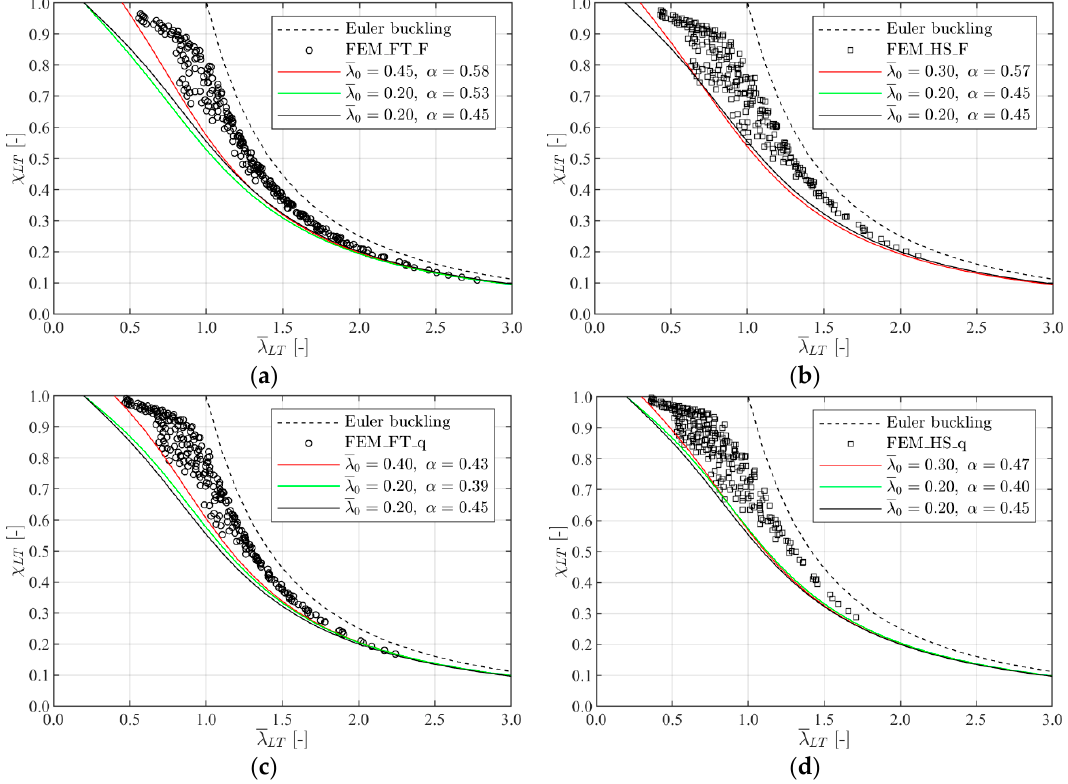
v L / 400 and φ = 0.01 rad , for different 0 0